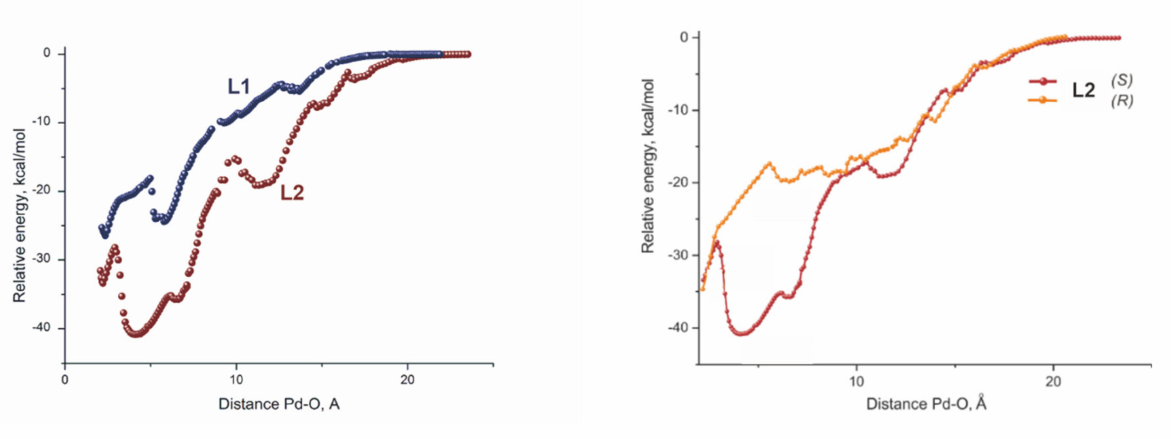
Figure 3. Scans of the relative energy versus the interatomic distance Pd–O. The structures of the ligands L1 and L2 are shown on the Scheme